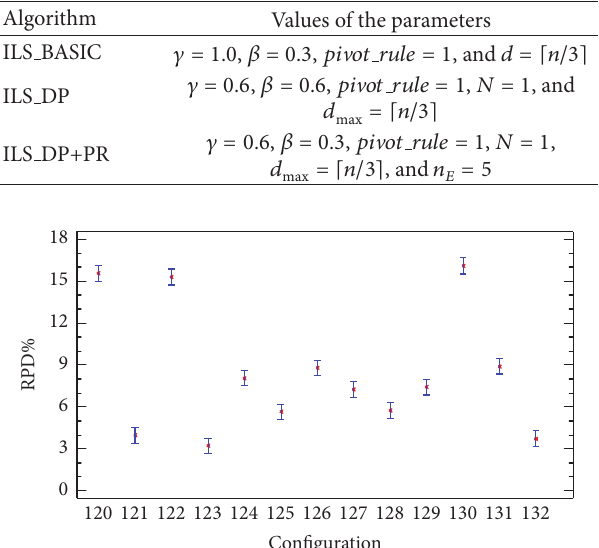
Figure 4: Means plot and Tukey’s HSD intervals at the 95% confidence level for 13 configurations of ILS